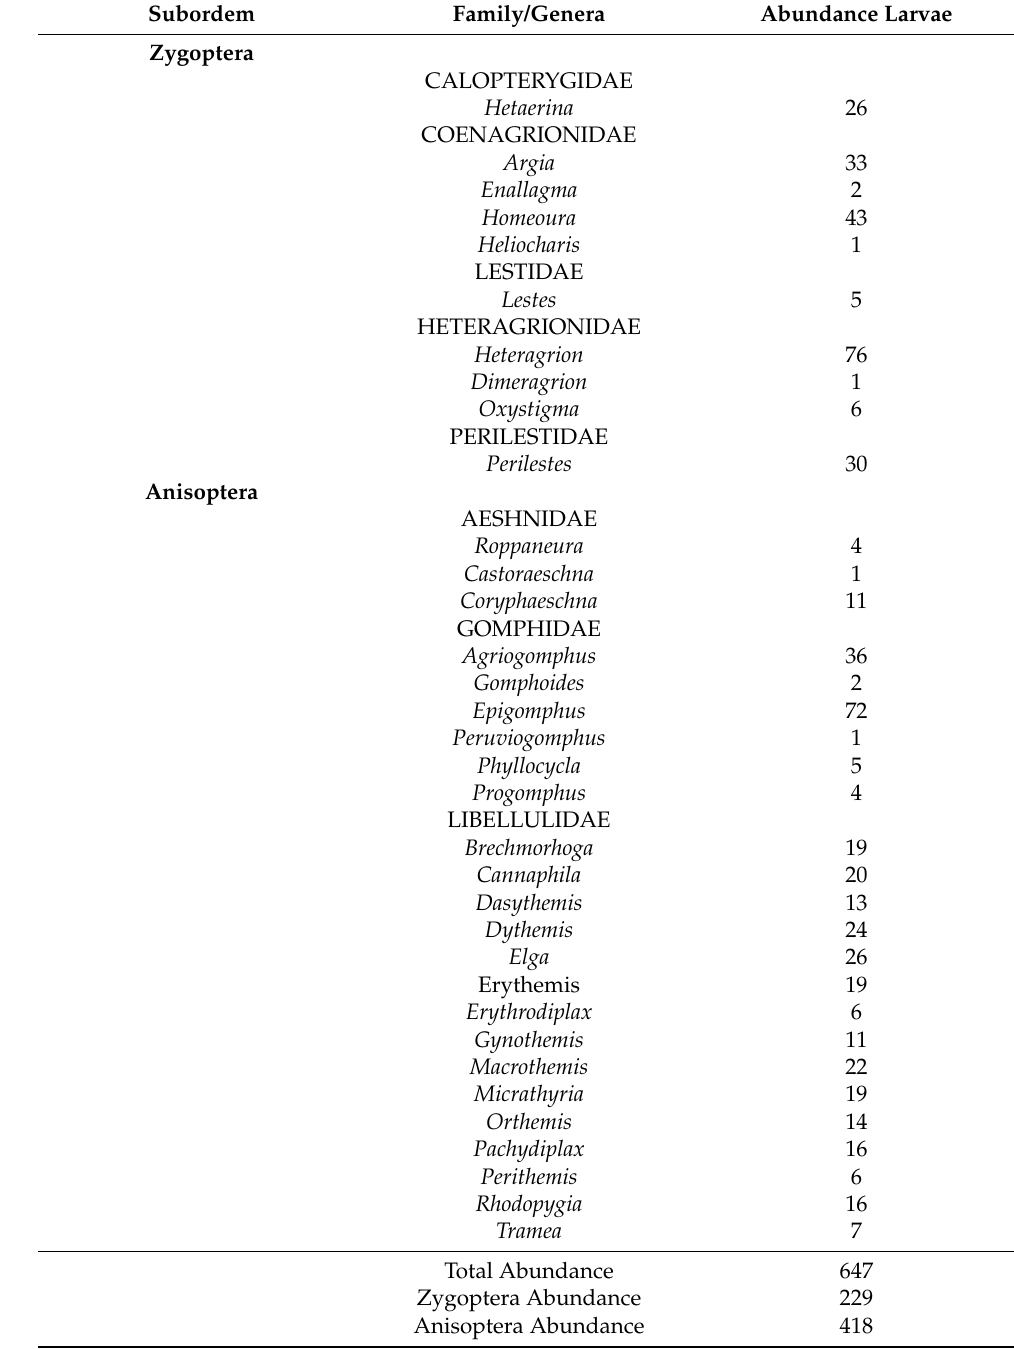
Table A4. Genera recorded in the cacao-cabruca areas, in the streams sampled in the southern region of